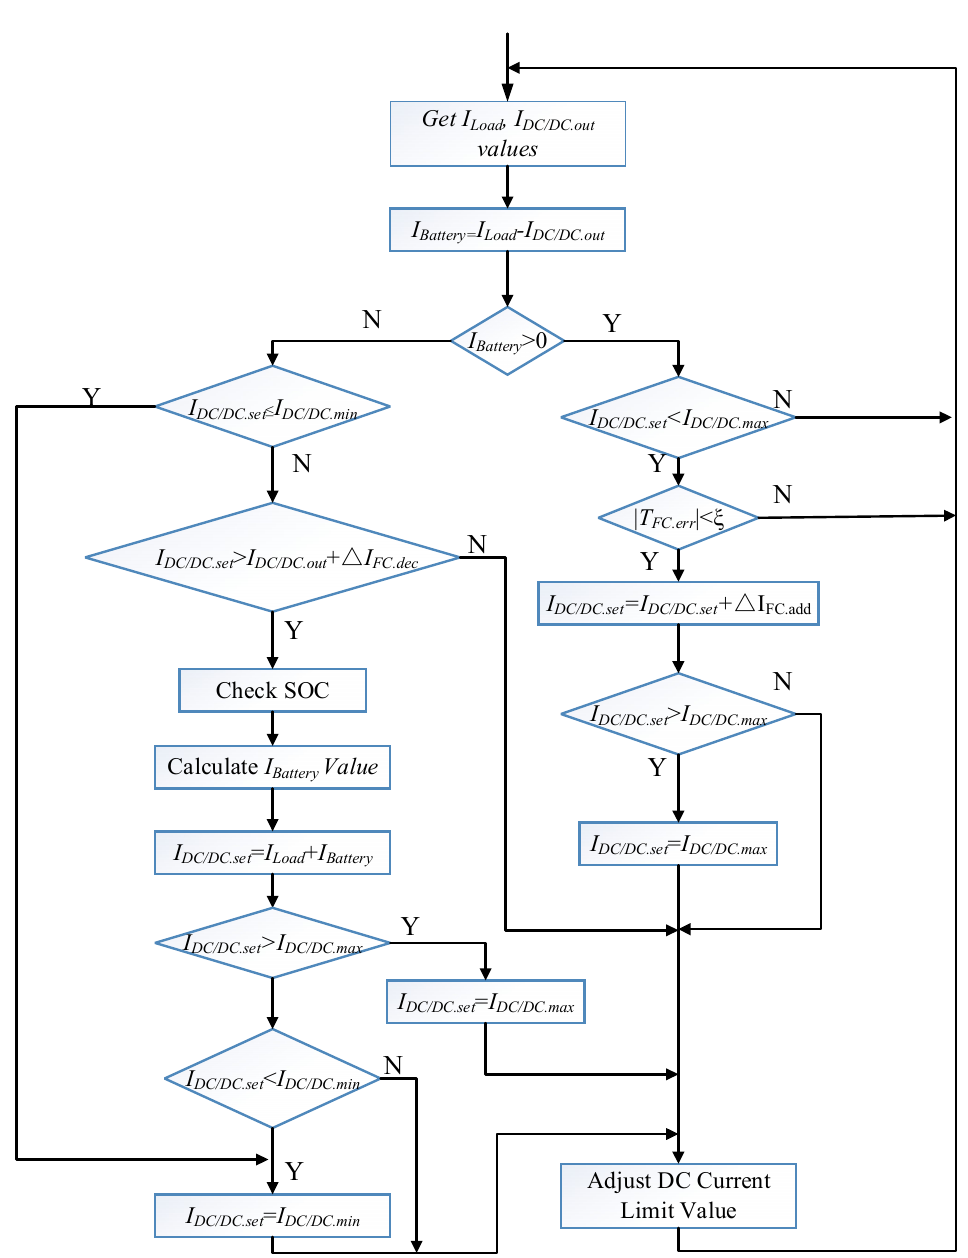
Figure 12. Control flow chart of energy management strategy.